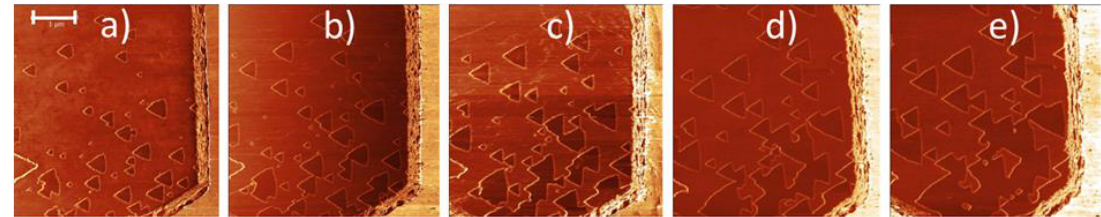
Figure 6. Growth of local triangular etch pits on thick MoS 2 crystals due to their heating. AFM investigations as a function of heating time on ~30 nm thick single MoS 2 flake. Scale bar 1 µ m. For better visualization, only one-way LFM ( ∼ friction) images are shown. Images from ( a − e ) were obtained after heating 10, 15, 20, 25 and 30 min at 370 °C, respectively. Reprinted from References [40], with permission. Copyright 2019 American Chemical Society.